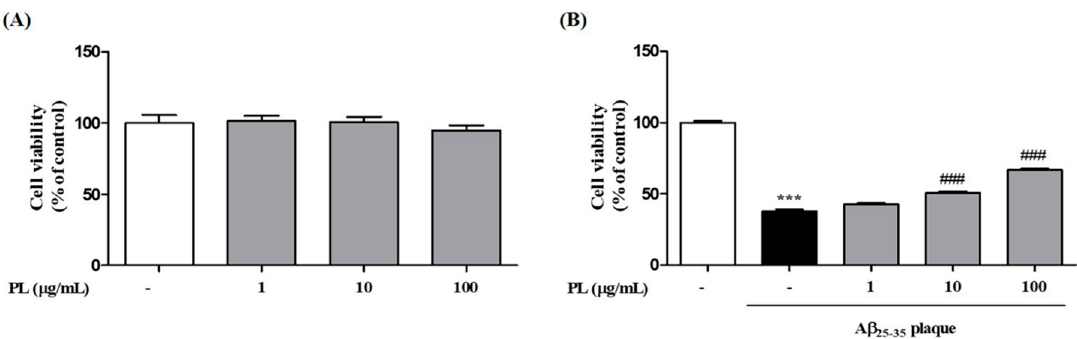
Figure 2. Effect of PL on cell death induced by A β 25–35 plaque in HT22 cells. HT22 cells were treated with PL (1–100 μ g/mL) for 1 h and incubated ( A ) without or ( B ) with A β 25–35 plaque (10 μ mol/L) for a further 23 h. Cell viabilities were measured by 3-(4,5-dimethylthiazol-2-yl)-2,5-diphenyltetrazolium bromide (MTT) assay 24 h after sample treatment and are presented as percentage of control. Values are mean ± standard error of the mean. *** p < 0.001 vs. control group, ### p < 0.001 vs. A β 25–35 plaque group.